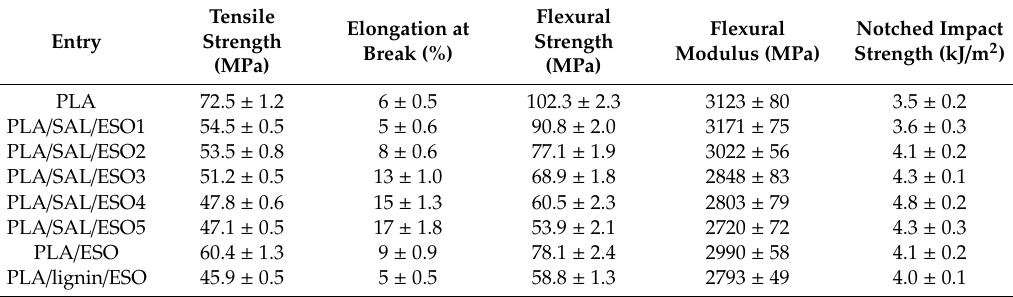
Figure 11. Tensile stress-strain curves of pure PLA, PLA/ESO, and PLA/SAL/ESO composites. Table 5. Mechanical properties of PLA, PLA/ESO, and PLA/SAL/ESO composites.